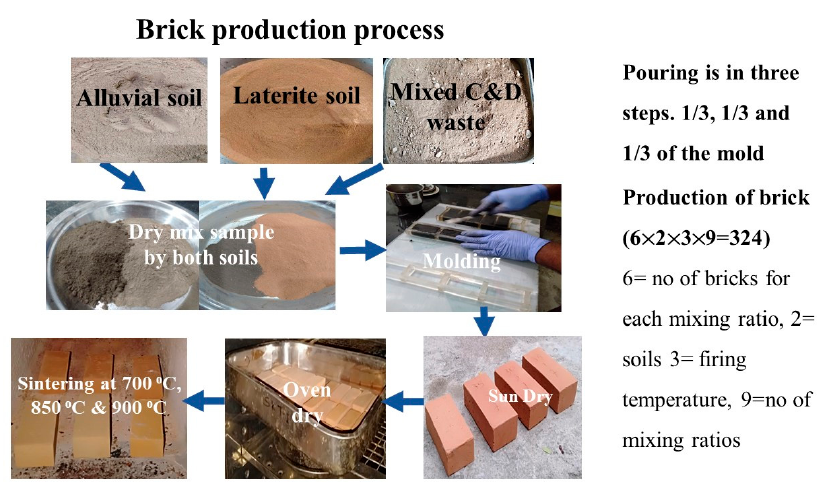
Figure 1. Fired brick production process.